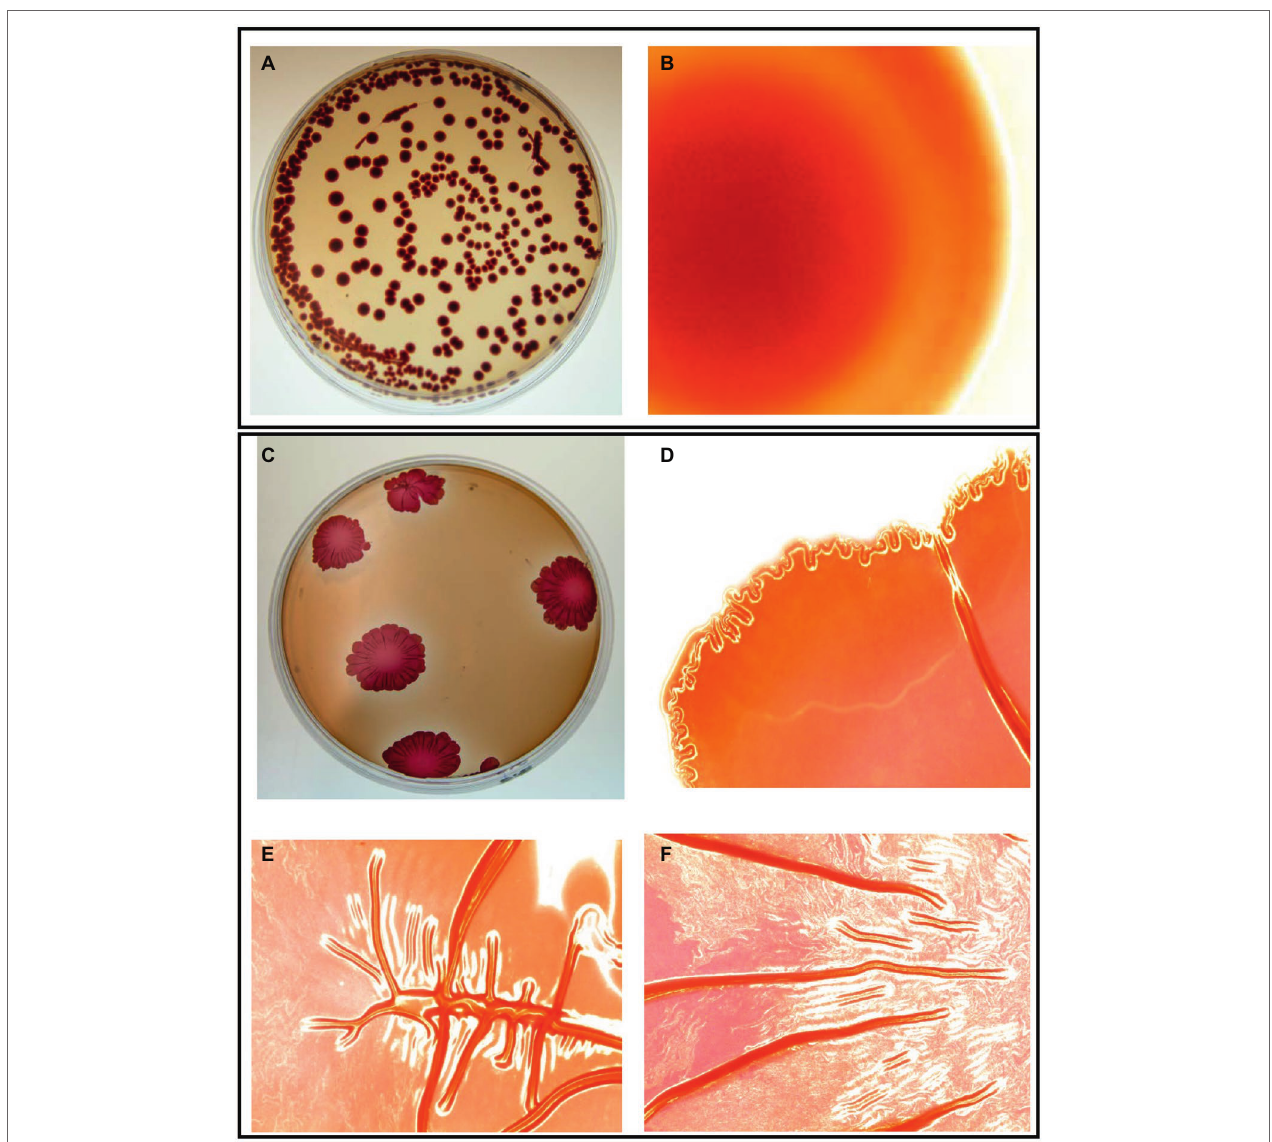
FIGURE 1 | Two distinct morphotypes of Salmonella Typhimurium ATCC 14028 growing on LB agar containing Congo red and coomassie brilliant blue at 37 ° C in 48 h. Smooth morphotype - (A) Typical round individual colonies, and (B) Round colony edges. Rugose morphotype developed after subinhibitory NaOCl exposure - (C) Characteristic red dry and rough (rdar) individual colonies, (D) Corrugated colony edges, and (E,F) Corrugated colony middle. Microscopic colony images (B,D,E,F) were taken using Life Technologies EVOS inverted digital microscope with 4X objective. Similar images were observed for S. Heidelberg ATCC